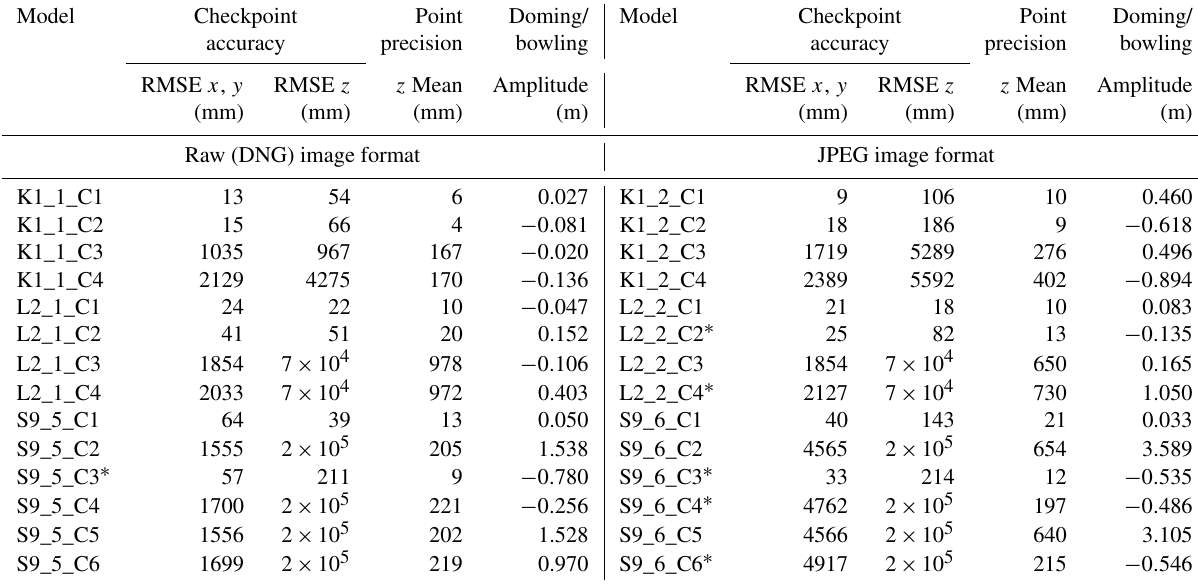
Table 2. Summary of topographic model uncertainty (i.e., SfM model quality). An ∗ indicates a model with a pre-calibrated camera model. We note here that the accuracy values for directly referenced models include systematic GNSS errors of up to 200m (S9) for the UAV platform, an issue that has been reported for the UAV platform family used in our study (e.g., Cook and Dietze, 2019). Model Checkpoint Point